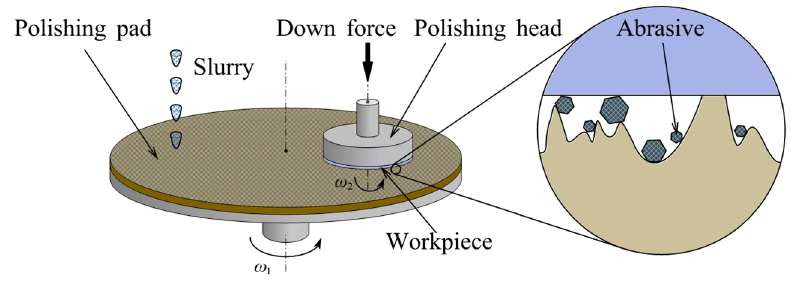
Figure 4. The schematic diagram of CMP [58].